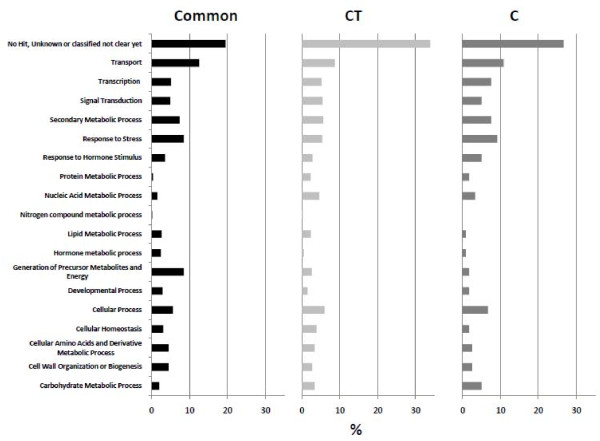
Distribution of common, CT and C highly modulated transcripts into 18 GO functional categories. Transport: GO:0006810; Transcription: GO:0006350; Signal Transduction: GO:0007165; Secondary Metabolic Process: GO:0019748; Response to Stress: GO:0006950; Response to Hormone Stimulus: GO:0009725; Protein Metabolic Process: GO:0019538; Nucleic Acid Metabolic Process: GO:0090304; Nitrogen Compound Metabolic Process: GO:0006807; Lipid Metabolic Process: GO:0006629; Hormone Metabolic Process: GO:0042445; Generation of precursor metabolites and energy: GO:0006091; Developmental Process: GO:0032502; Cellular Process: GO:0009987; Cellular Homeostasis: GO:0019725; Cellular amino acid and derivative metabolic process: GO:0006519; Cell wall organization or biogenesis: GO:0071554; Carbohydrate metabolic process: GO: 0005975. Percentages were calculated on the total number of modulated genes for each dataset.